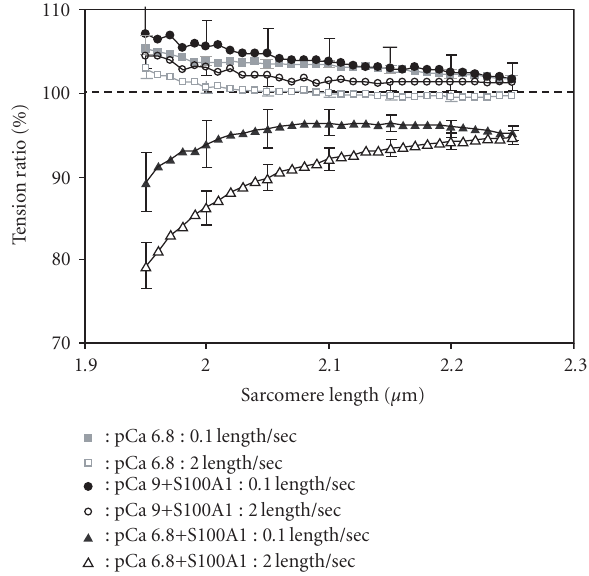
Figure 6: E ff ect of calcium, S100A1, and calcium plus S100A1 on tension. Skinned MLV was stretched at two velocities (0.1 and 2.0 length/sec; dark and open symbols, resp.) in calcium alone (pCa 6.8; grey), S100A1 alone (circles), or calcium plus S100A1 (triangles). Calcium alone or S100A1 alone slightly increases tension (3–8%). When S100A1 is added to pCa 6.8 solutions, tension is decreased, an e ff ect that is largest at the fastest stretch speed. Tensions are expressed relative to tensions measure in the pCa 9.0 solution (See methods for details). Error bars are SE (for clarity plotted only every 0.05 μ